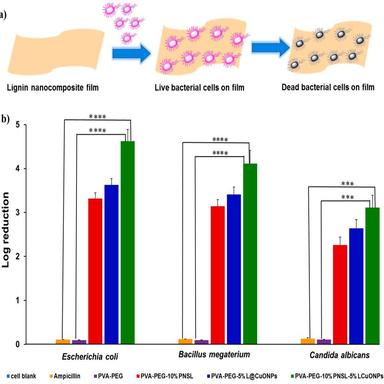
a) Schematic presentation of antimicrobial activity of lignin nanocomposite films; b) Log reduction of tested microorganisms treated with nanocomposite films (PVA-PEG, PVA-PEG-10%PNSL, PVA-PEG-5%L@CuONPs, and PVA-PEG-10%PNSL-5%L@CuONPs tABpor), and ampicillin (log reduction ± SD, n = 3). The concentrations of PVA-PEG, PVA-PEG-10%PNSL, PVA-PEG-5%L@CuONPs, PVA-PEG-10%PNSL-5%L@CuONPs, and ampicillin were 100, 100, 25, 60, and 100 μg/ mL against E. coli, B. megaterium and C. albicans, respectively. (\\\\P < 0.